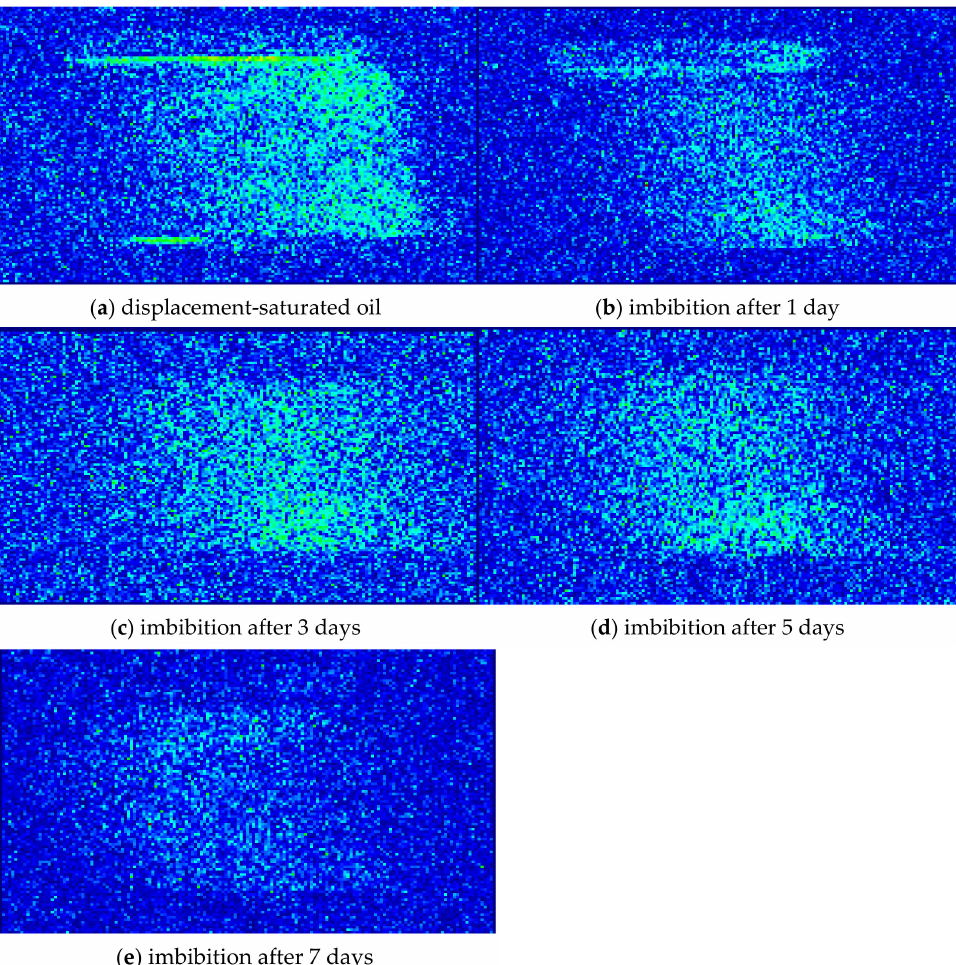
Figure 5. Pseudo-color processing images of core 1 (fluorescence represents oil